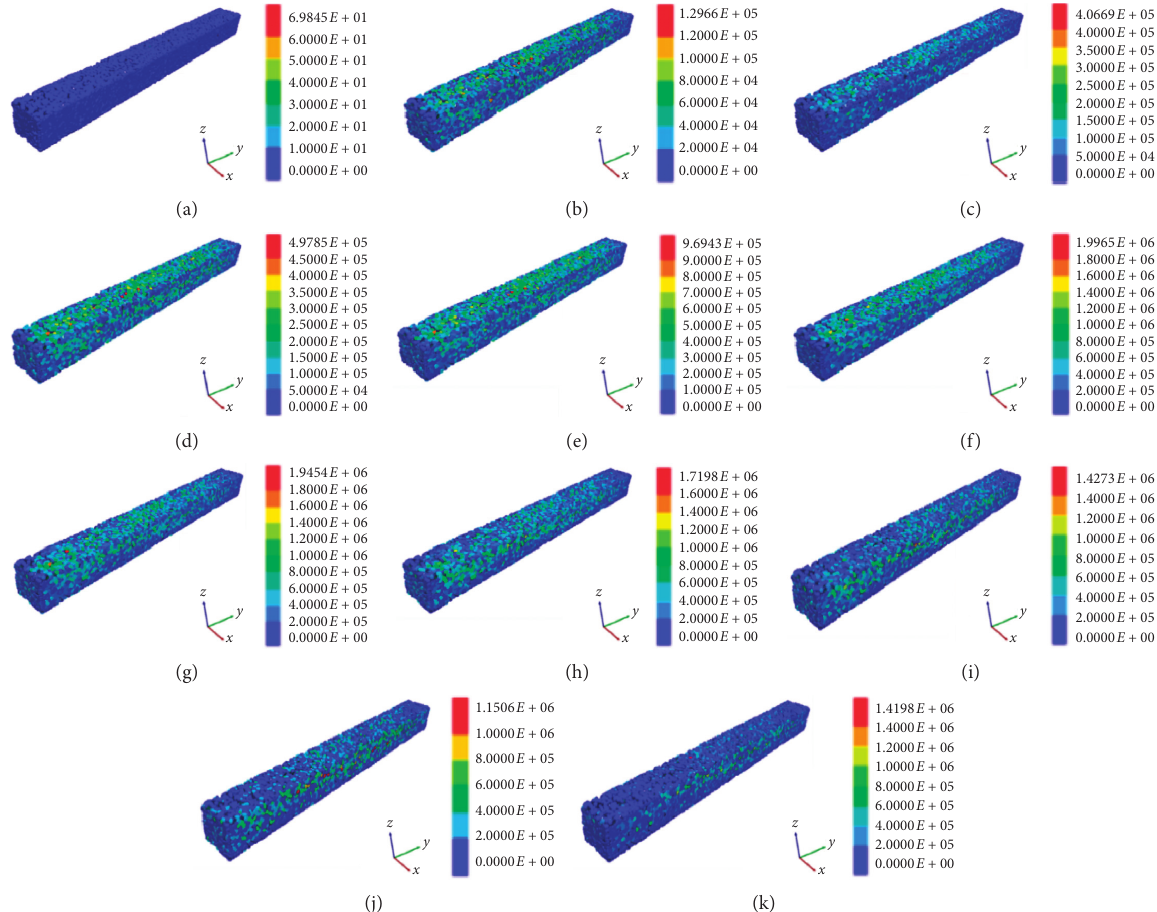
Figure 15: Contact force between granular coal and cross-cut with working face advancing. (a) 0 m. (b) 16 m. (c) 32 m. (d) 48 m. (e) 64 m. (f) 80 m. (g) 84 m. (h) 88 m. (i) 92 m. (j) 96 m. (k) 100